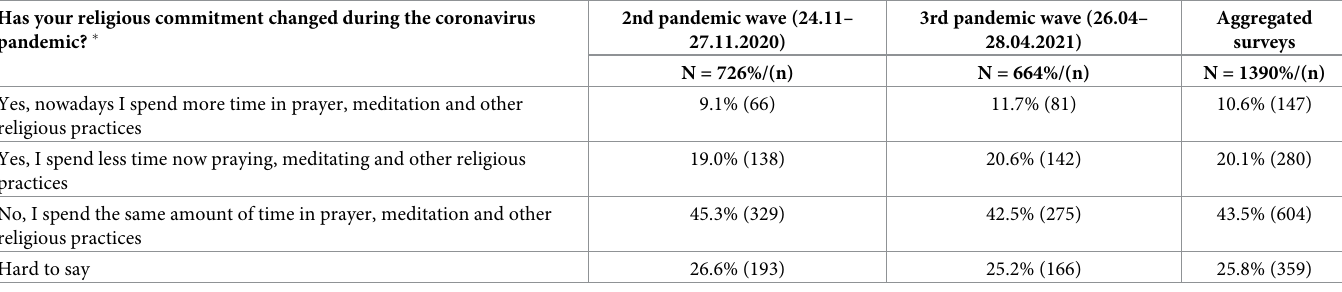
opinions did not change significantly between the second wave of the pandemic and the third (Table 3).